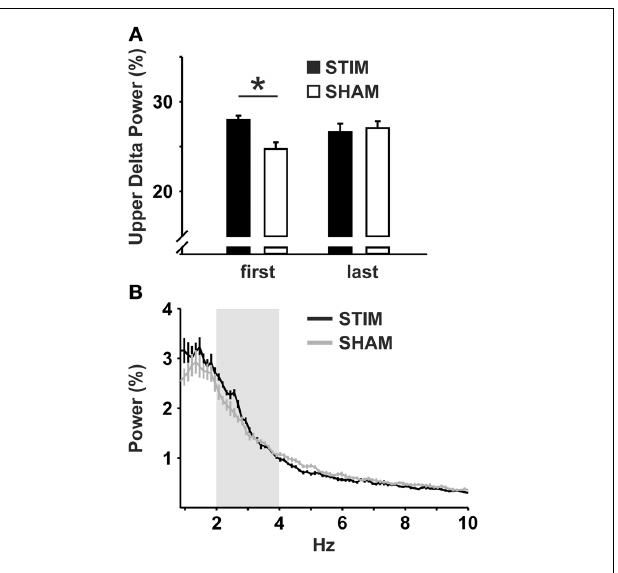
FIGURE 3 | Upper delta power within the 10s intervals of post-stimulation NREM sleep. (A) Mean upper delta power (2.08–4.03Hz) within the first and the last post-stimulation interval of the day across all 12 experimental days. ANOVAs for repeated measures followed by post-hoc t -tests. ∗ p < 0 . 05. (B) Mean power spectra within all 10s intervals of post-stimulation NREM sleep across all 12 experimental days. Upper delta band is marked in light gray. Note the peak at ∼ 2.5Hz in the STIM, but not in the SHAM